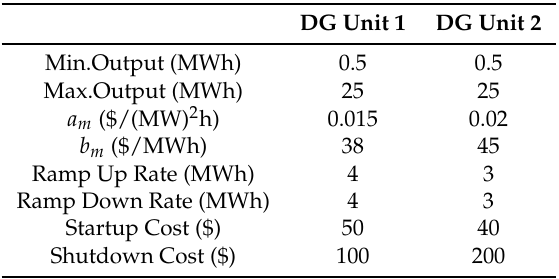
Table 2. Parameters of distributed generation (DG) units.